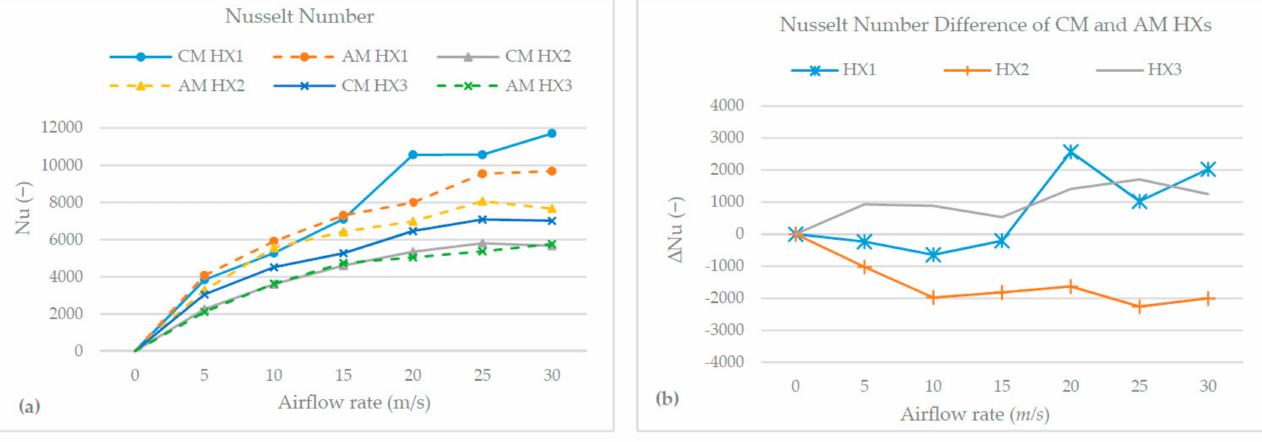
Figure 5. Experimental results when the heater temperature was 50 ◦ C: ( a ) Nusselt number and ( b ) Nusselt number difference between the CM– and